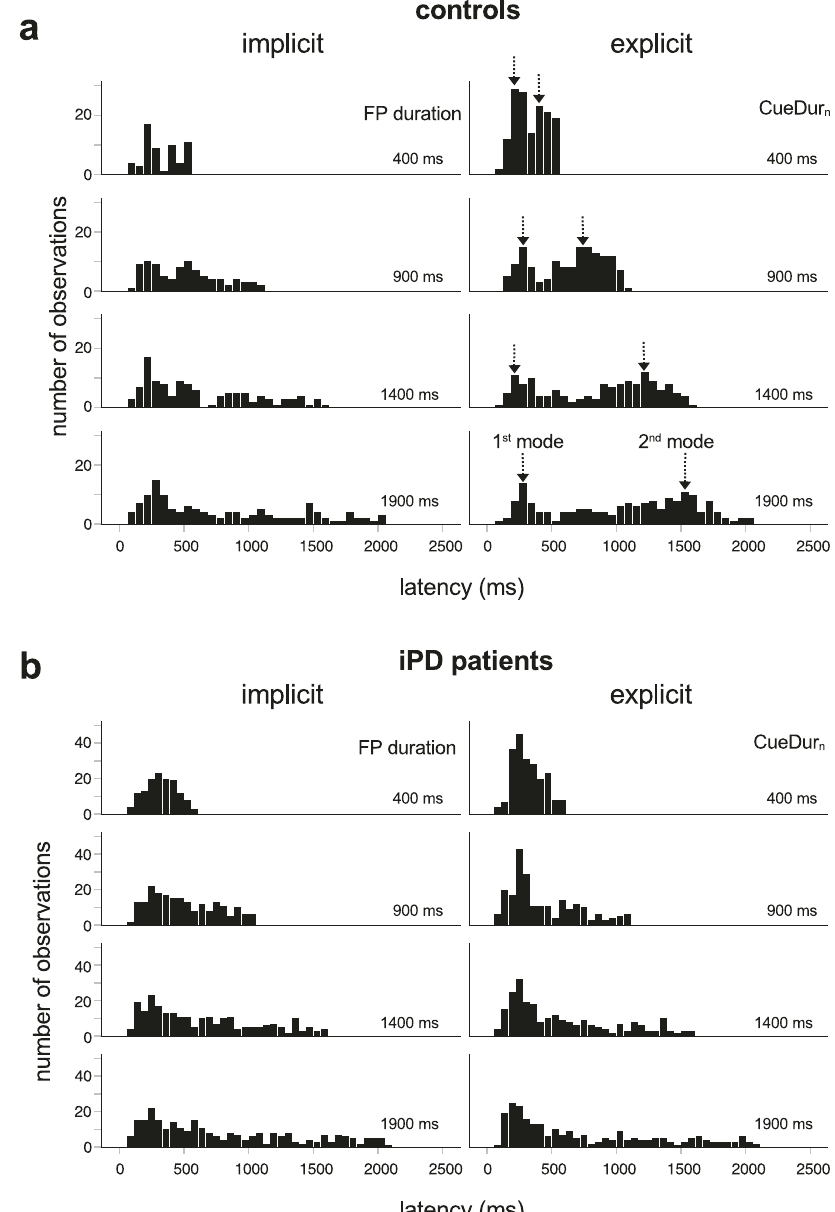
Fig. 3 Histograms of latency distributions. Early saccades in controls ( a ) and iPD patients ( b ). Left column: implicit timing; right column: explicit timing. Vertical arrows are centered on the peak of the 1 st and 2 nd modes of the explicit latency distributions in controls for illustrative purposes. Saccadic latency was measured with respect to the offset of the WS (time ‘ zero ’ on the